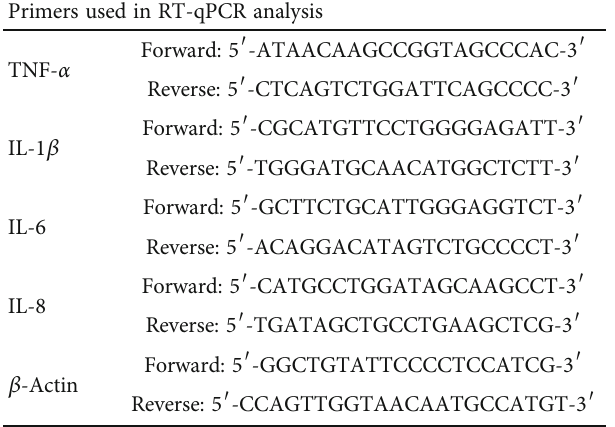
Table 1: Primers used in RT-qPCR, ChiP analysis, and si-RNA